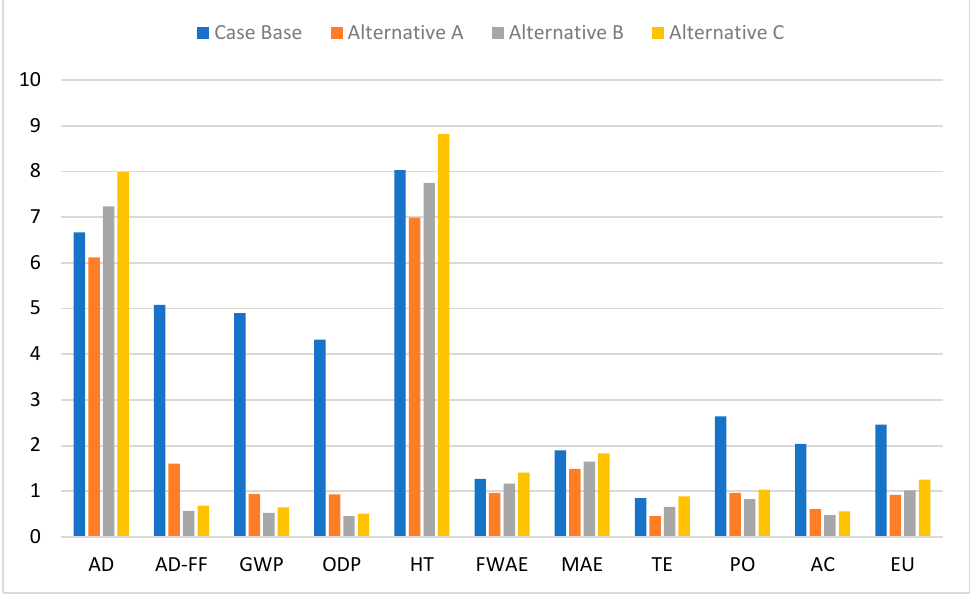
Figure 6. Bar chart of the years of environmental amortisation by category for the different alterna- tives.